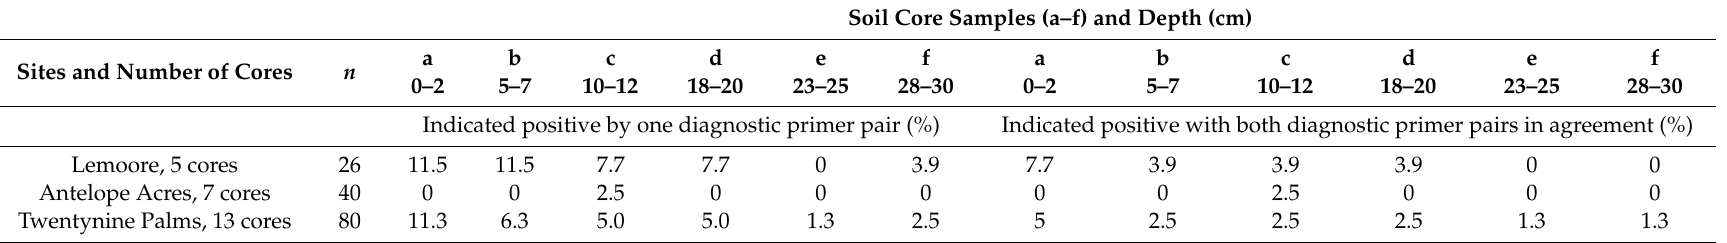
Table 7. Positive diagnostic PCR results (ITSC1f / r and EC3f / EC100r) for all DNA extracts from soil core samples (cores: n = 25, individual soil samples: n = 146) collected around NAS Lemoore, Antelope Acres and MCAGCC Twentynine Palms in